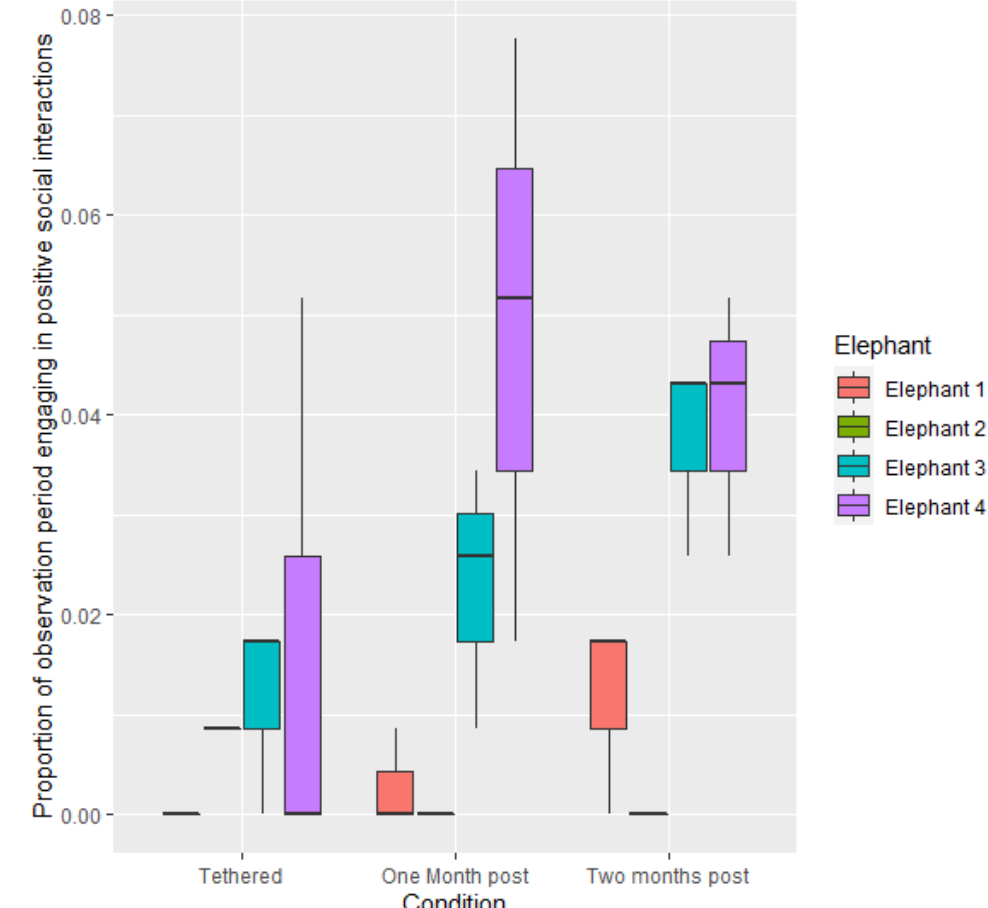
Figure 3. Mean proportion of time spent engaging in positive social interactions per observational period during the three conditions.